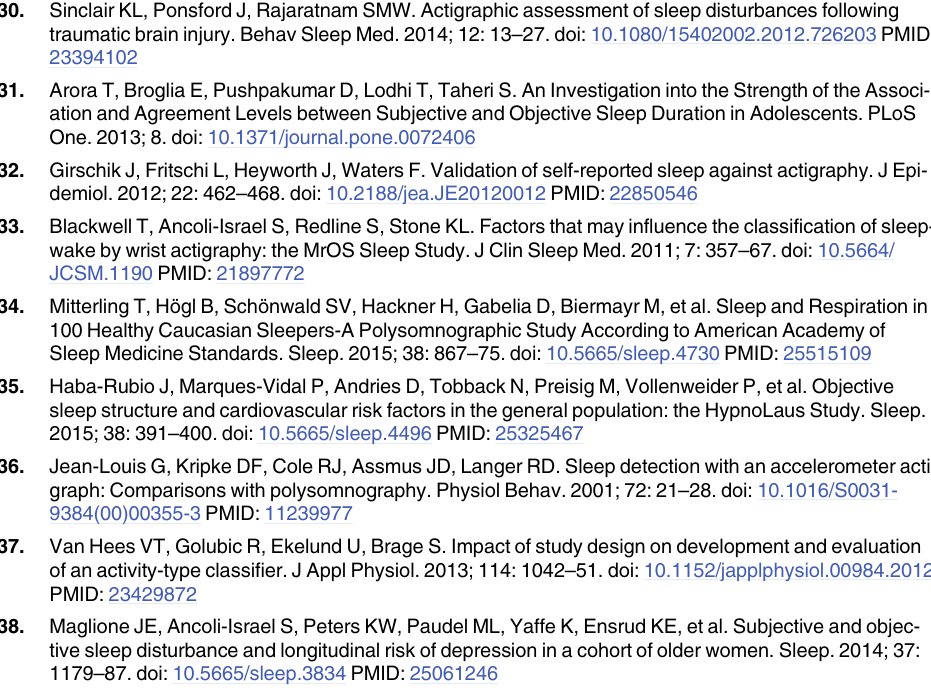
PLOS ONE | DOI:10.1371/journal.pone.0142533 November 16,